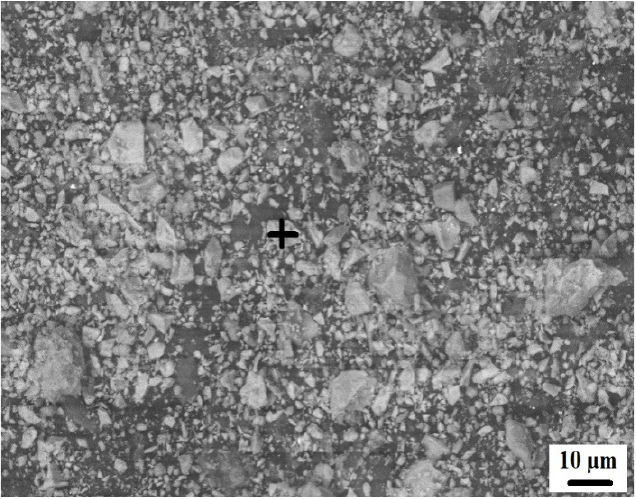
Figure 3. Microstructure of untreated coal ash.